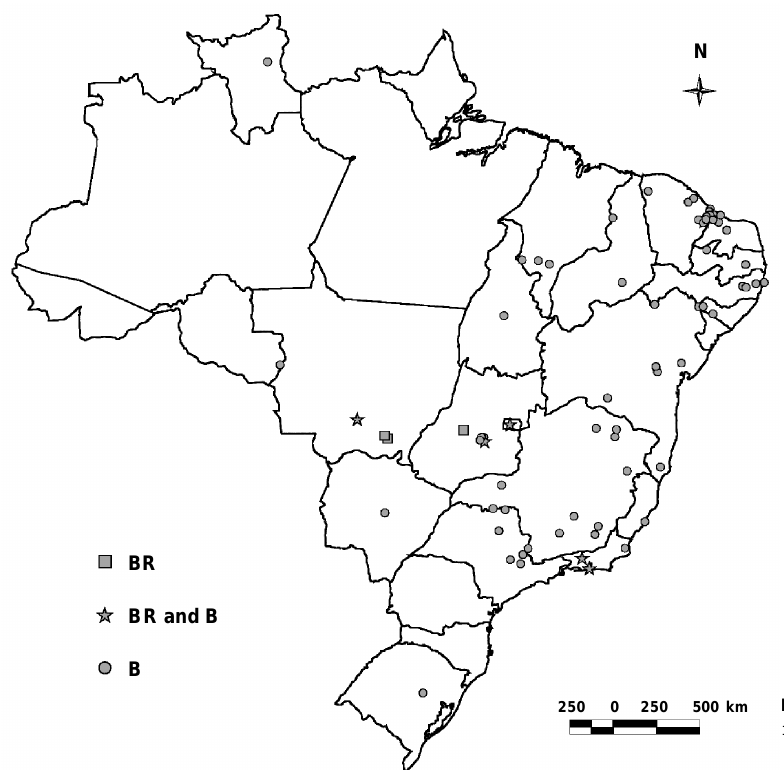
Figure 2 - Distribution of B. tabaci collected in Brazil and identified by RAPD